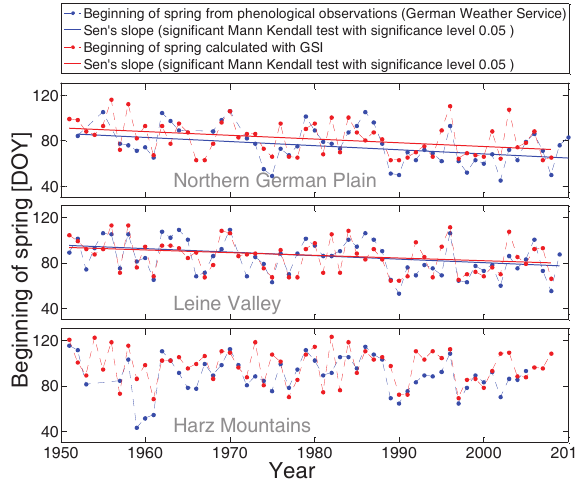
Fig. 3. Beginning of spring as observed (blue) and calculated (red) for three different sites in Lower Saxony. GSI scales leaf area index (LAI), vegetation fraction, albedo and vegetation height on a daily time step, with minimum values referring to winter time and maximum values